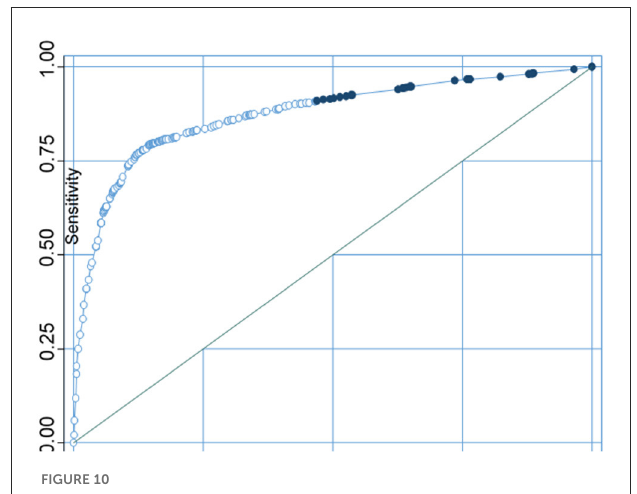
FIGURE9 Sub-group analysis of improved sanitation facility by educational status.